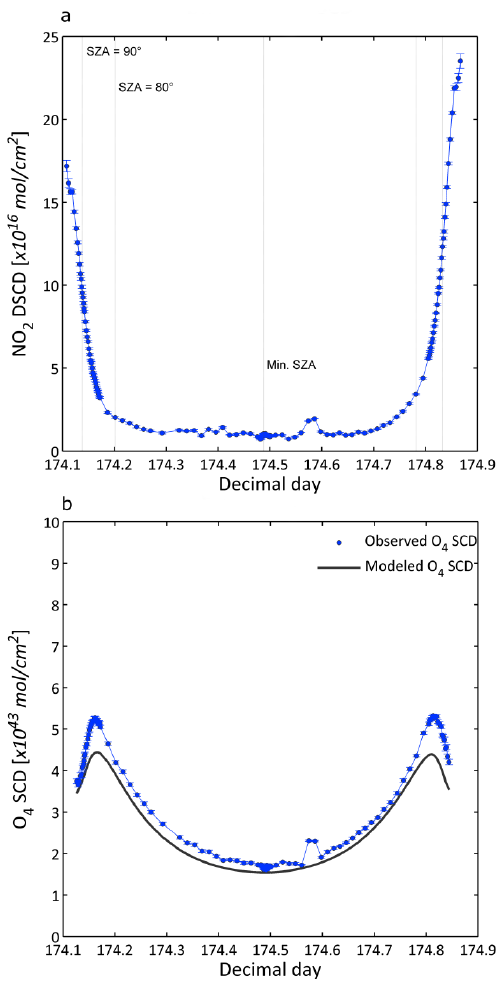
Figure 3. NO 2 and O 4 slant column diurnal cycle for the non- polluted, clear-sky reference day 174 (23 June 2009). (a) The NO 2 DSCD diurnal cycle, dominated by stratospheric absorption, has a typical u-shape with minimal tropospheric perturbations. (b) The observed O 4 SCD diurnal cycle largely follows the smooth curve, modelled with the RTM